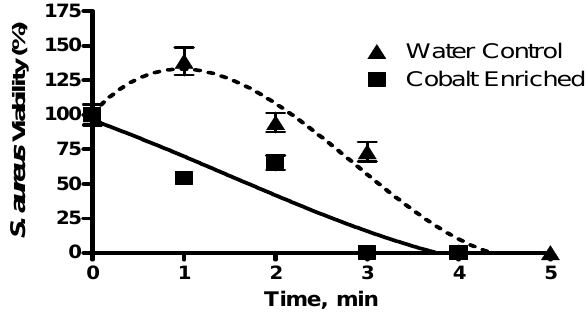
Figure 3: Effect of cobalt ions on microwave disinfection of S. aureus. Demonstrates the effect that cobalt ions (solid line) have on the deactivation of S. aureus (n=10) during microwave heating compared to a distilled water control (dotted line).